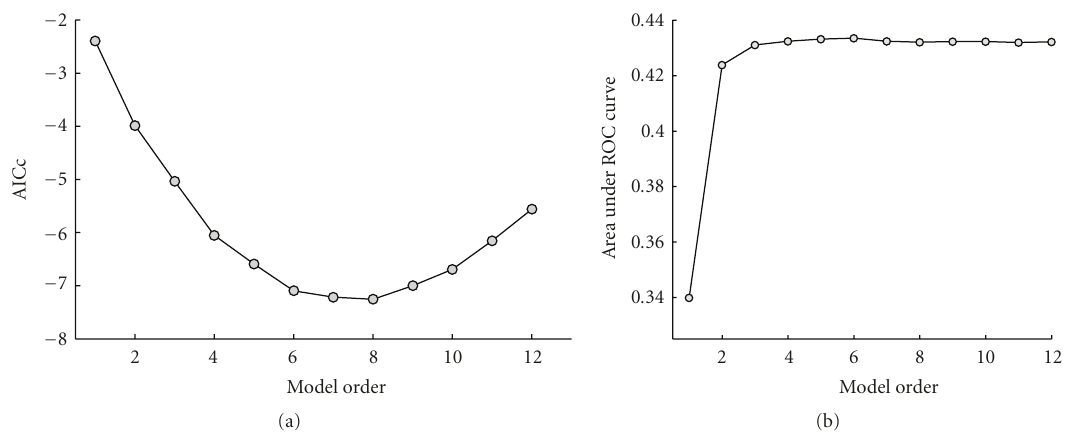
Figure 8: (a) The corrected Akaike Information criterion is computed for both datasets SR1 and SR2 and then averaged. The AICc criterion indicated a model order between 6 and 8, where the minimum was at p = 8. (b) ROC curve related to prediction error of the AR model on the training data was computed in the center and right windows and averaged over both datasets SR1 and SR2.